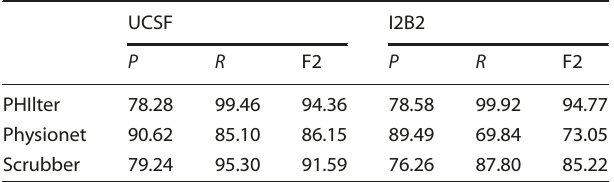
Table 1. Performance comparison of tools and corpora.